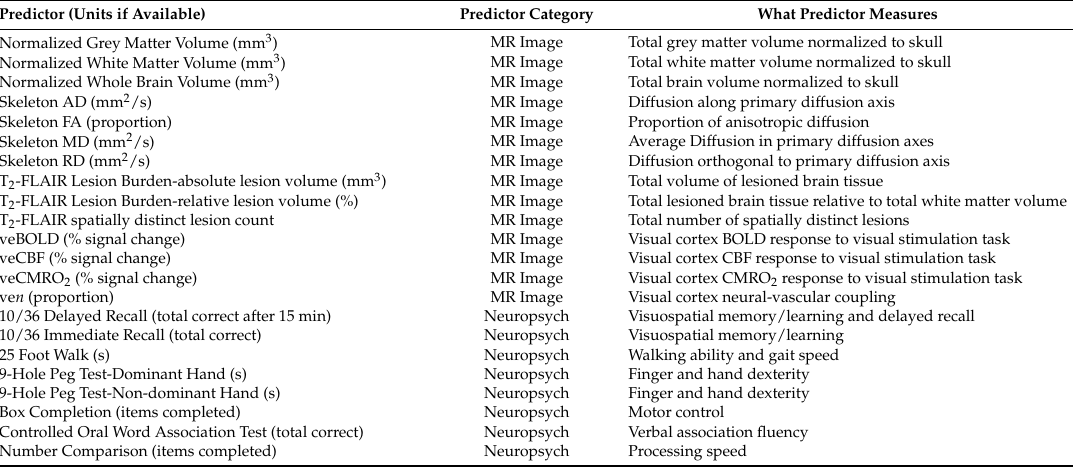
Table 2. Predictor